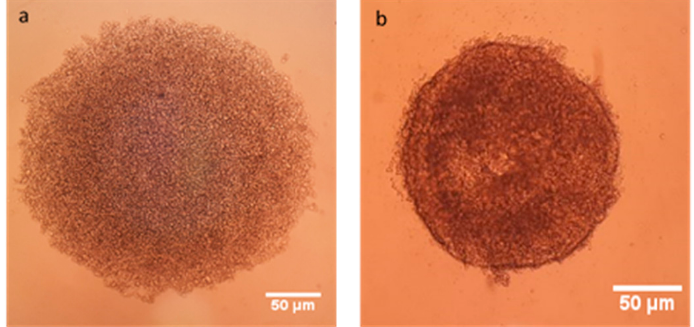
Figure 10. MCF-7 cells after centrifugation ( a ) and 3D MCF-7 spheroid after 7 days ( b ).